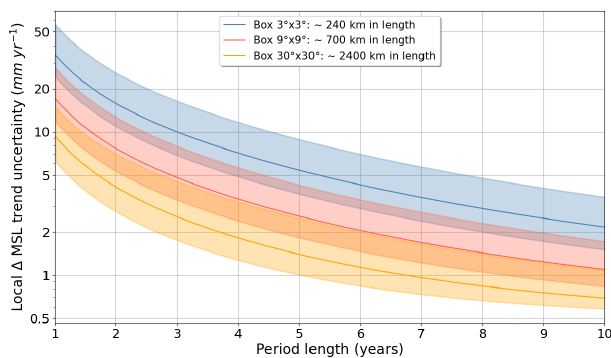
Figure 6. Evolution of the S3A–Jason-3 regional MSL trend uncer- tainties as a function of period length for different box sizes. The solid line is the global median of regional MSL trend uncertainties. The envelope represents the spatial distribution of uncertainties at between the 16th and 84th percentile (i.e., 1 σ ) values. The y -axis scale is